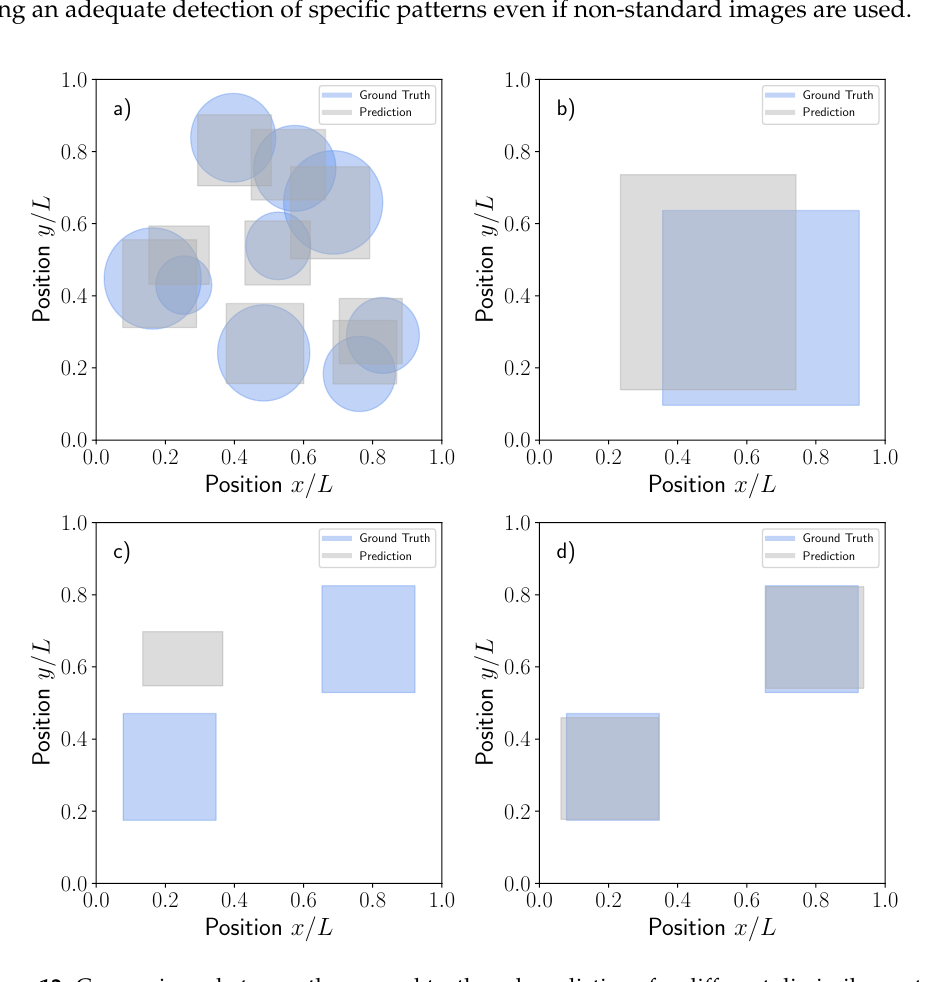
Figure 12. Comparisons between the ground truth and predictions for different dissimilar material realizations: ( a ) Circular, ( b ) Double size rectangular, ( c ) Two equal rectangles, ( d ) Two equal rectangles with CNN model trained with a new double rectangle data